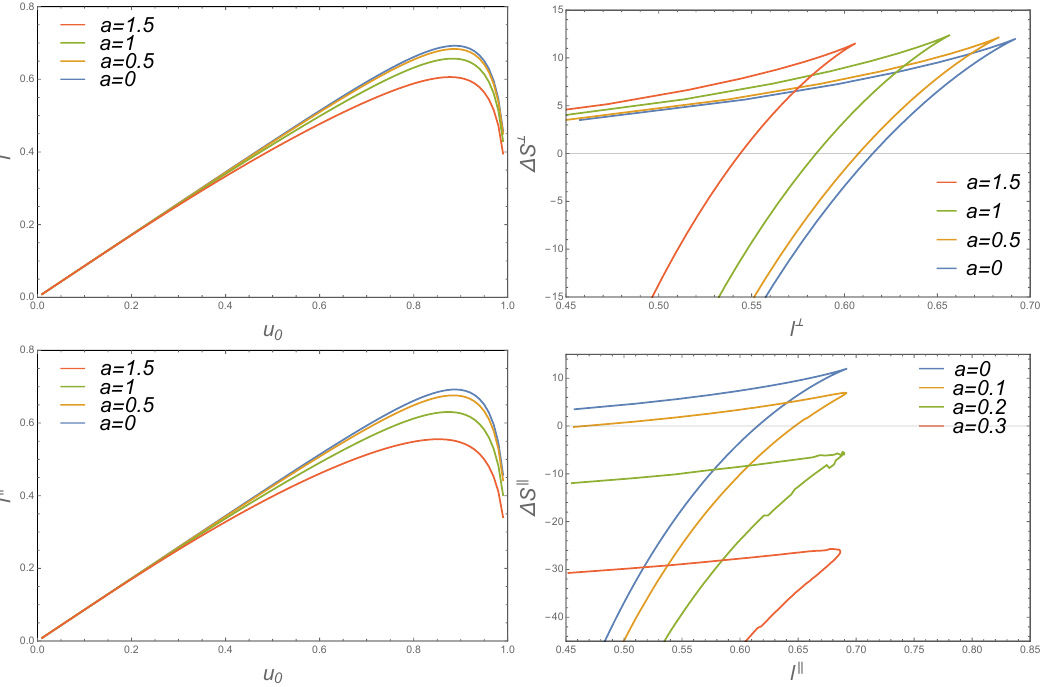
Figure 6 . The behavior of width and entanglement entropy in perpendicular and parallel case. Upper: the relation of l ⊥ and u 0 , ∆ S ⊥ and l ⊥ for perpendicular case. Lower: the relation of l k and u 0 , ∆ S k and l k for parallel case. We can see the typical swallow-tail behavior representing phase